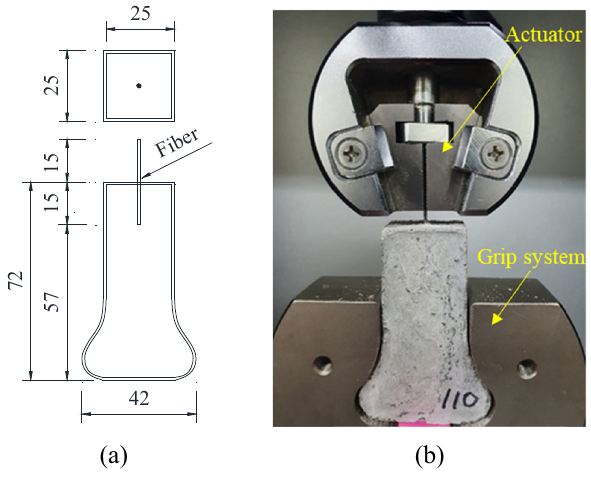
Figure 4: Test setup and dimensions of a specimen ( unit: mm ) . ( a ) Dimensions of the specimen and ( b ) pullout test setup.